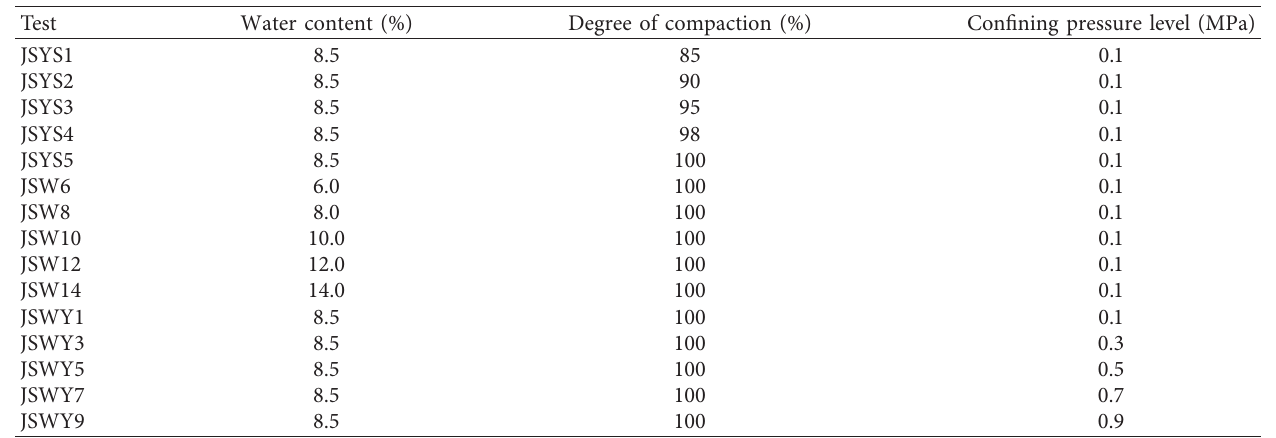
Table 2: Test procedures of natural soils.